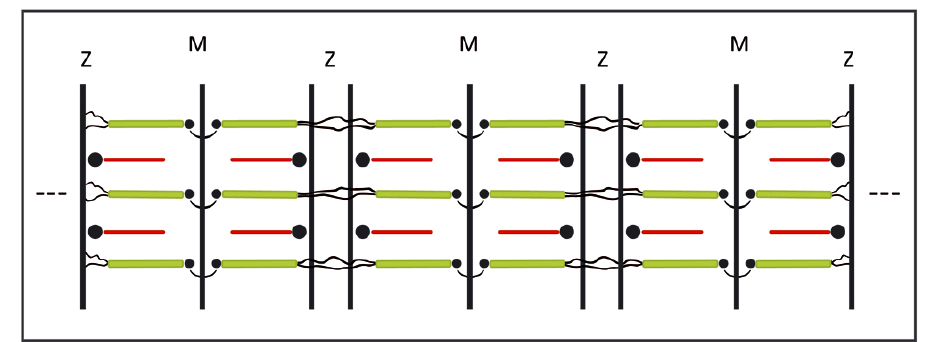
Figure 1. Schematic representation of three sarcomeric repeating units along the polymeric myofibril. The contracted state of the muscle is evidenced by the interpenetration of the thick (green) and the thin (red) filaments. The thin filaments are based on rigid actin molecules bound to tropomyosin and troponin and anchored to the Z-zone by the cross-linking protein α -actinin. The thick filaments are based on rigid myosin molecules bound to up to six semi-flexible titin molecules (dark) bound to the M line and to the Z zones. Each sarcomer includes two half-sarcomers specularly connected at the M line. Titin is the only component that spans the entire length of each sarcomer and of the myofibril. Neighboring sarcomers polymerize by bridges of α -actinin that links two titin NH 2 terminals that emanate from each thick filament. An elongated membrane envelops the myofibril.